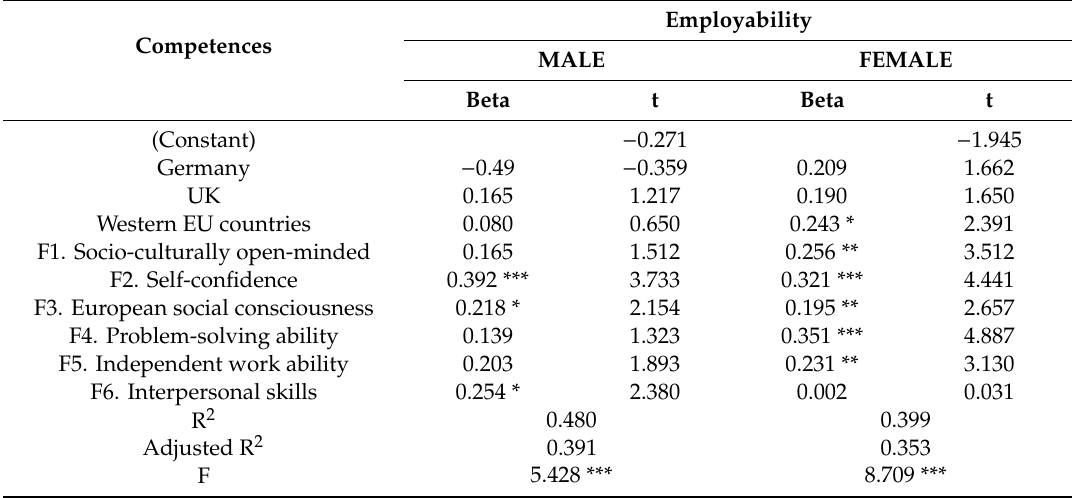
Table 8. Regression models: gender perceptions about employability